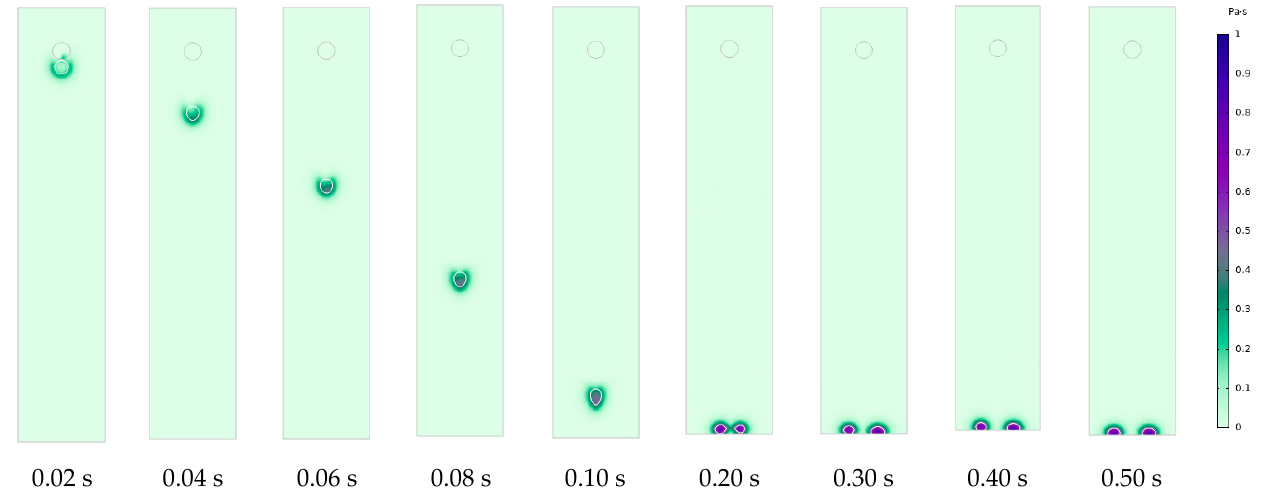
Figure 13. Viscosity of the water droplet in air at 263.15K.